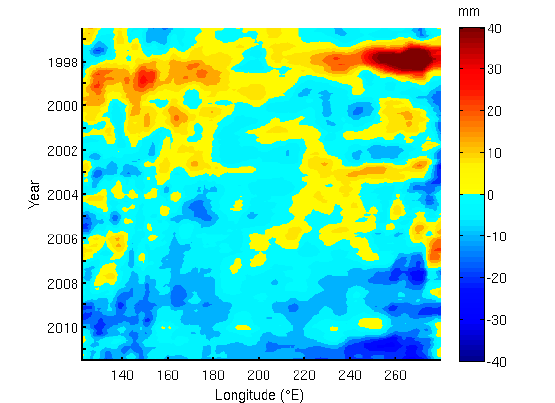
Fig. 6. Longitude/time diagram of the north Pacific (0-60°N) ocean mass from 1996 to 2011 based on the difference between altimetry- based sea level data and IK12 steric data. Units: